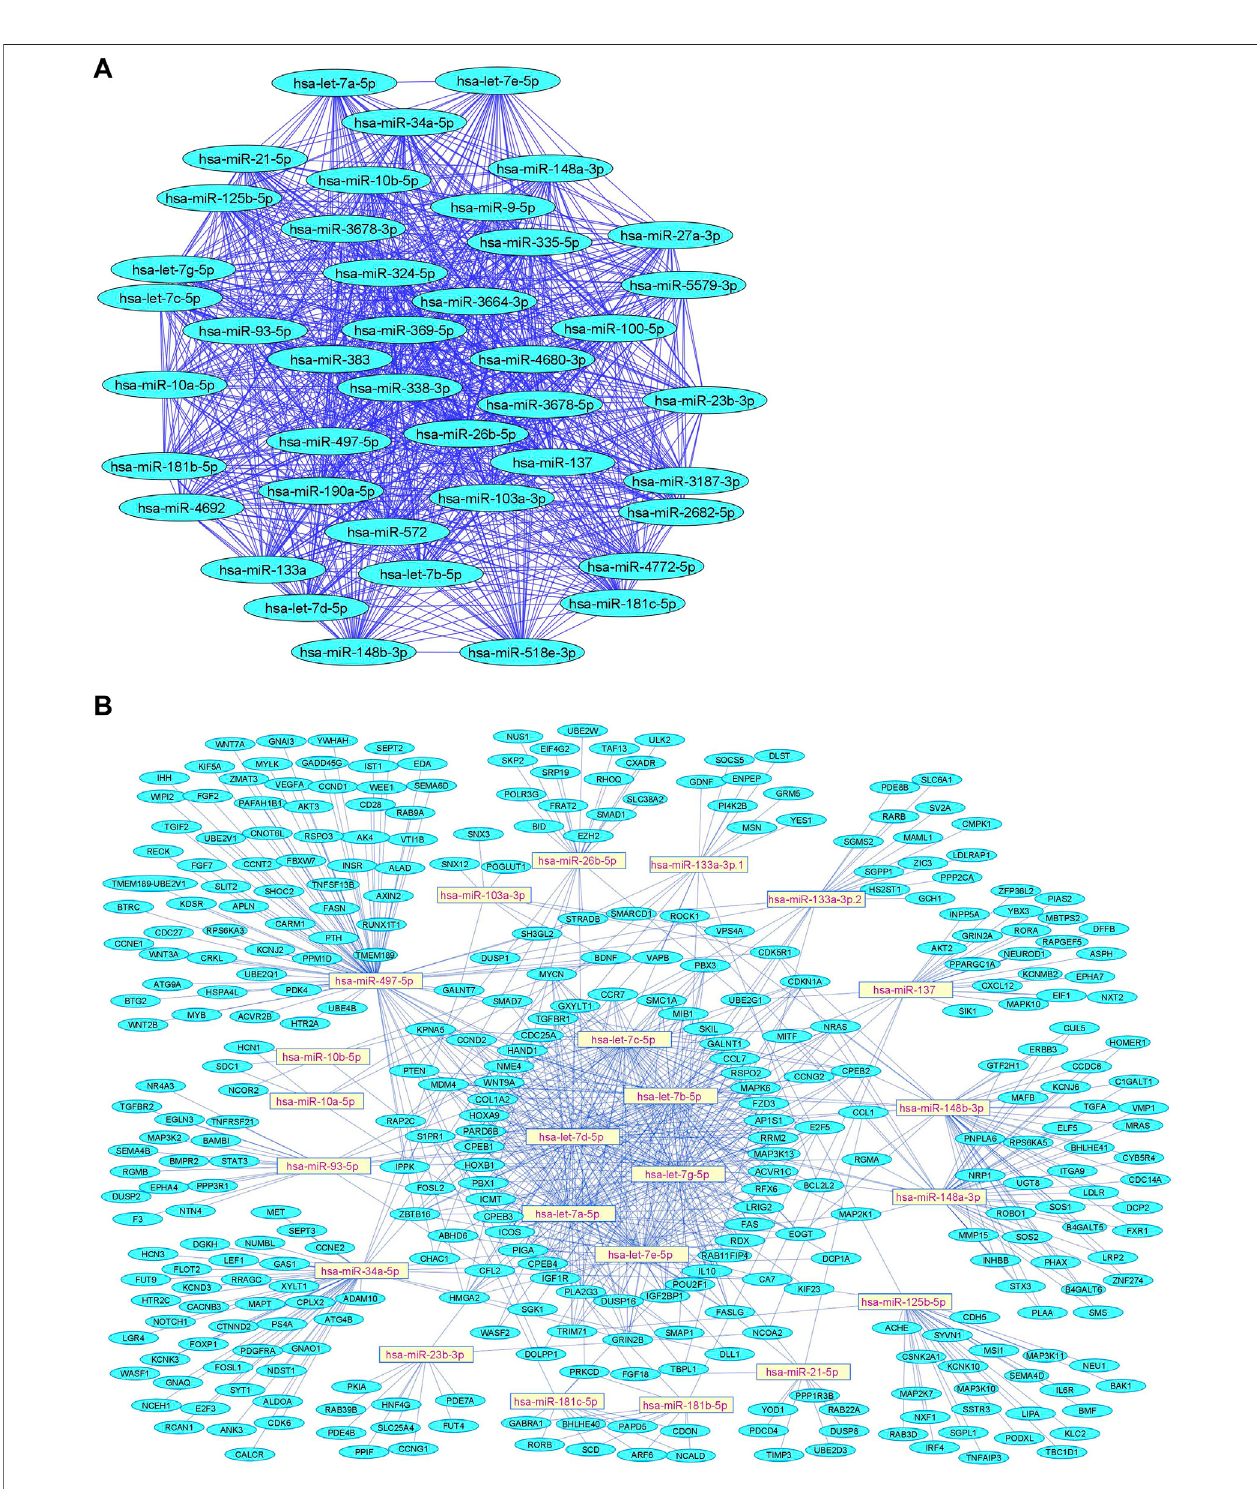
FIGURE 4 | Downregulated human microRNA networks in neuropathic pain: (A) Human microRNA – microRNA network: Human miRNA-miRNA interaction networkwith42nodesand861edges.ThenetworkswereconstructedusingCytoscape3.8.2. (B) HumanmicroRNA – genetargetnetwork:Architectureofnetworksof upregulated miRNAs in humans implicated in neuropathic pain showing interaction network of functionally enriched miRNAs with their targets with 380 nodes and 759 edges.ThenetworkswereconstructedusingCytoscape3.8.2.UsingMienturnet,themiRNA-targetinteractionswereidenti fi edbyTargetScanandthefunctionally enriched miRNAs were generated using the KEGG